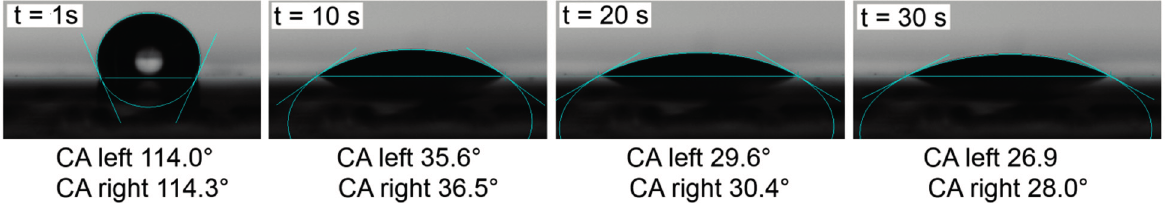
Figure 7. Time-dependency of the contact angle between separator COATED and mixture M-2 as a representative for all electrolyte mixtures and both